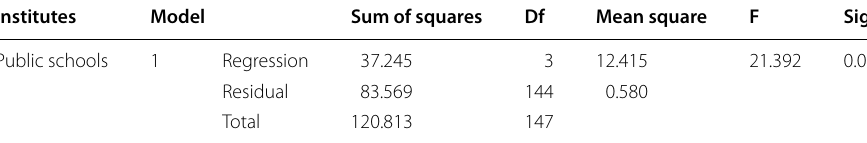
Table 10 The ANOVA a results for the public school students